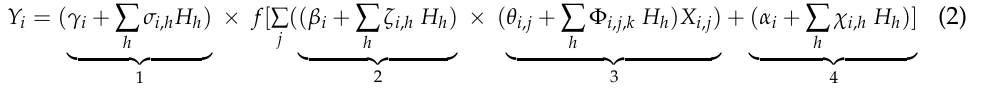
where i, h, and j represent the neurons of the input, hidden and output layers, f () is the activation function of the neuron. ∂ , ζ , Φ , and χ are the parameters for activation function weight (Term 1 in Equation (2)), summation function (Term 2 in Equation (2)), input value (Term 3 in Equation (2)), and bias value (Term 4 in Equation (2)) that control the hormonal levels, respectively. The neural weights are represented as γ , β , θ , and α . in Equations (3) and (4), respectively.